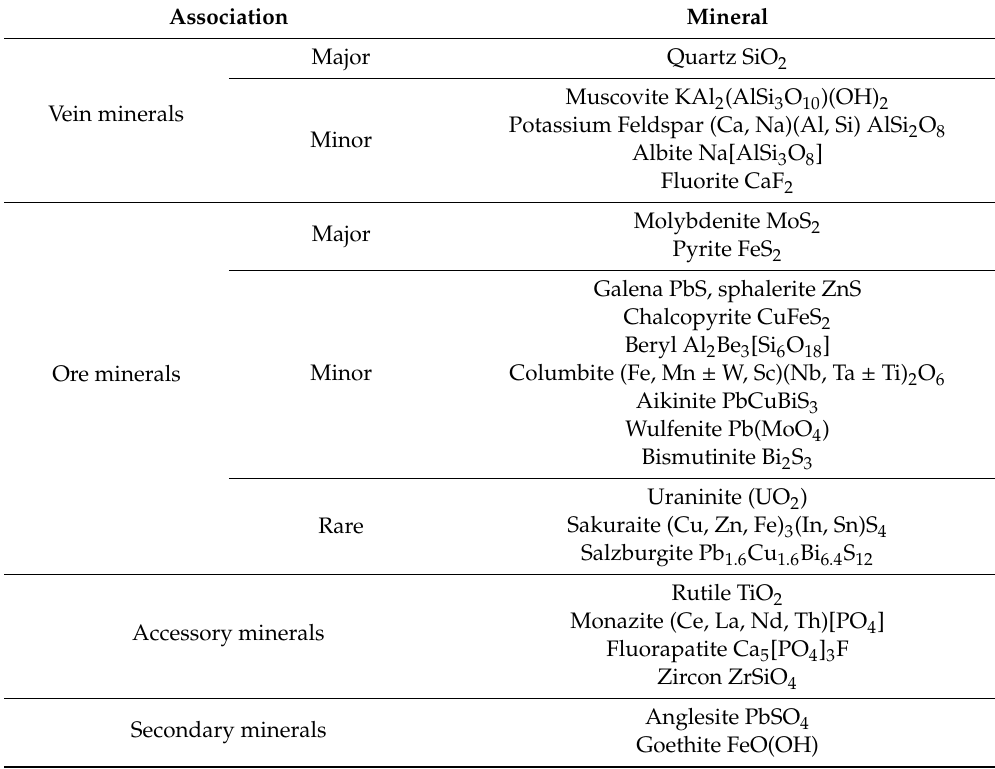
Table 3. Mineral composition of quartz-molybdenite